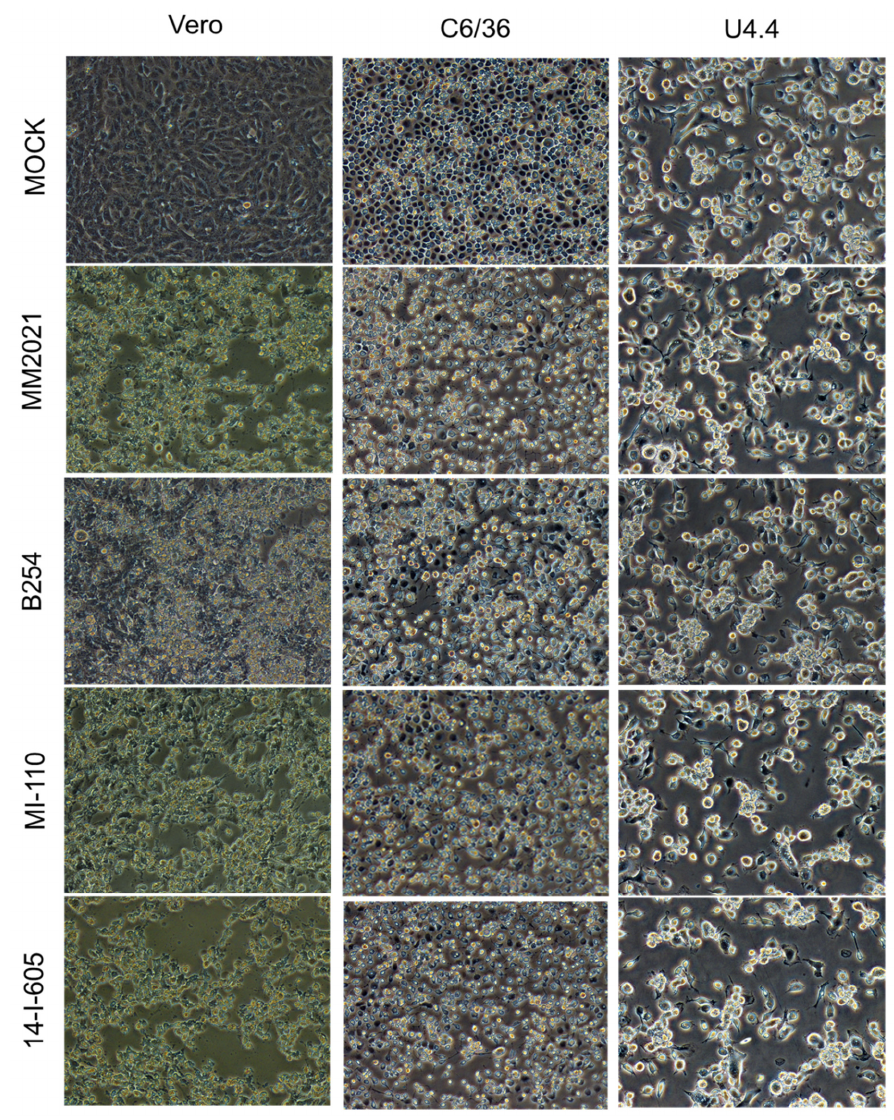
Figure 4. Cytopathic effects of GETV infection in Vero, C6/36, and U4.4 cells. Cells were infected with various strains of GETV at MOI of 0.1 and cytopathic effects (CPE) was observed at 48 hpi (200× magnification). Relatively more apparent CPEs were observed in the GETV-infected Vero and C6/36 cells, where the cells were shrunk, rounded, and refractile-appearing as compared to the larger and dark-appearing cells in the mock infections. No apparent CPE was observed in the GETV-infected U4.4 cells.